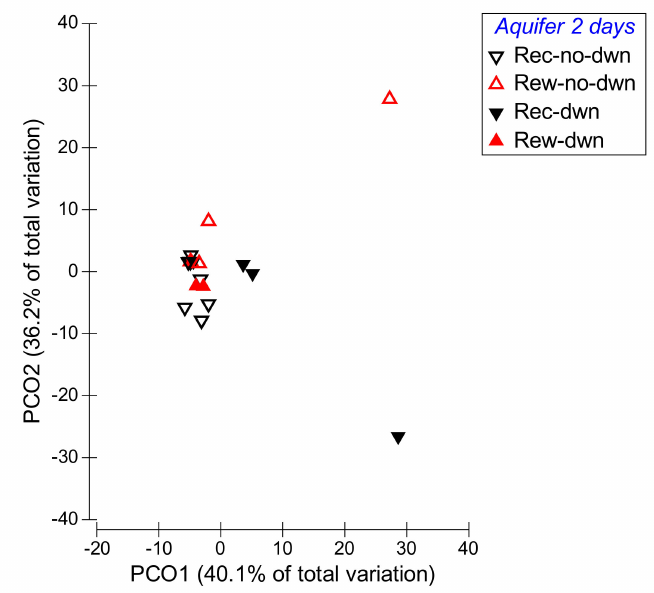
Figure 5. PCoA, for significant PERMANOVA models run for stygobites (2 days: time interval used for calculation of the hydrological phases). Aquifer phase codes as in Table